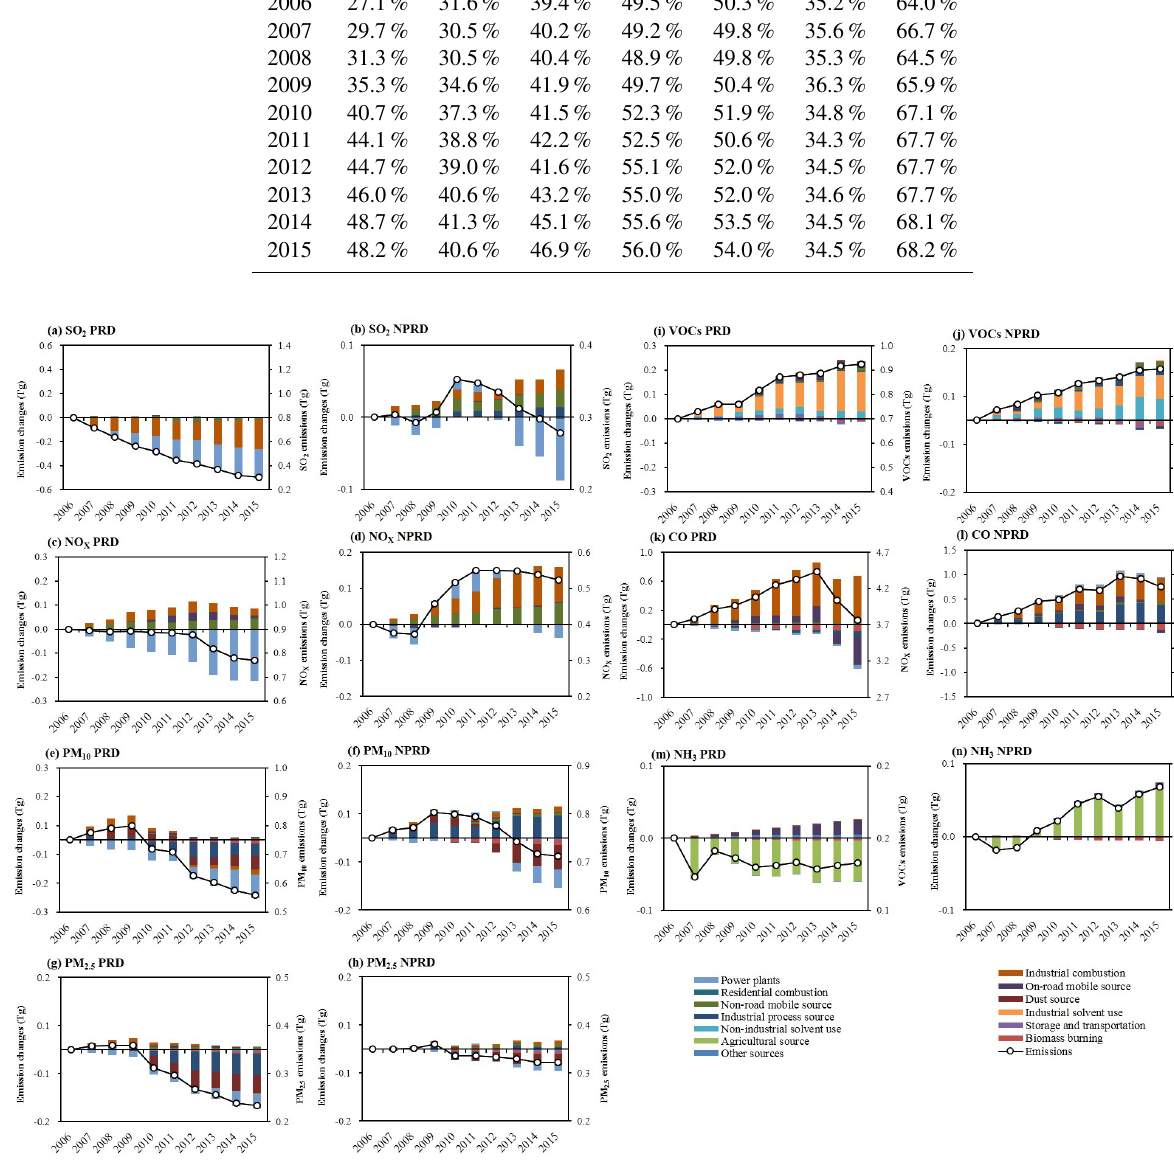
in PM 2 . 5 emission trends, with decreases of 35 % in PRD and 9 % in